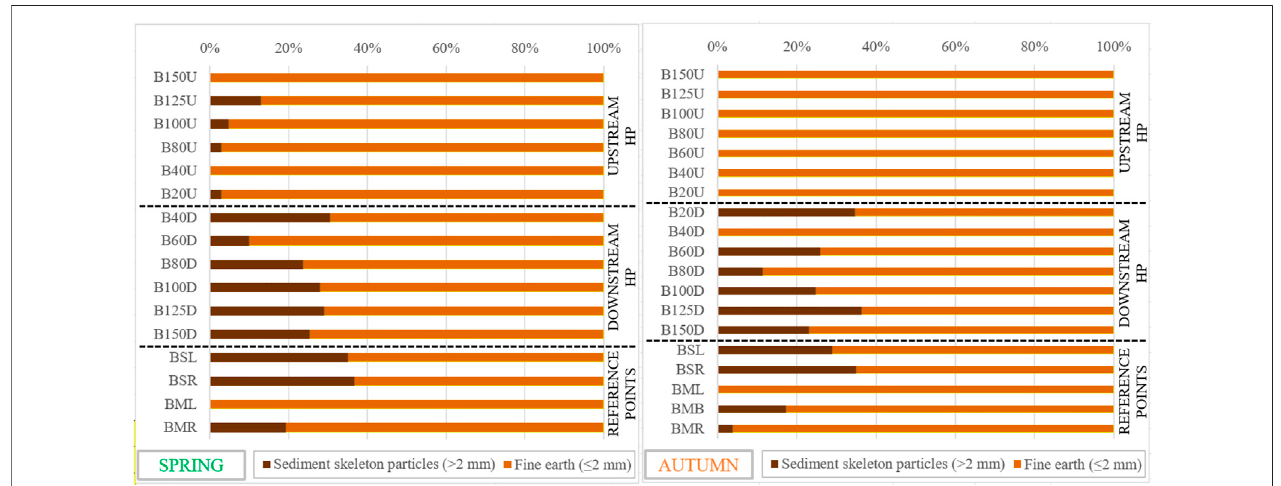
FIGURE 7 | The share of skeleton particles and fi ne Earth fractions in the tested sediment samples from the Bystrzyca River.